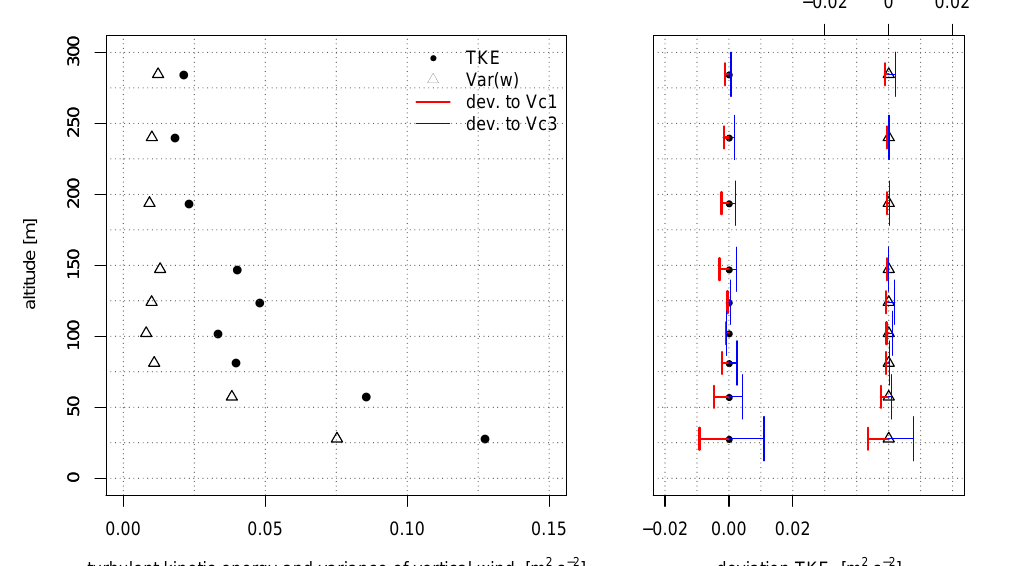
Figure 7. Height profiles of the ISOBAR flight with the altitude AMSL of the turbulent kinetic energy TKE and the variance of the vertical wind component Var( w ), calculated with the calibration polynomial at v c 2 ( left ). Deviations ( right ), when applying the calibration polynomials at v c 1 and v c 3